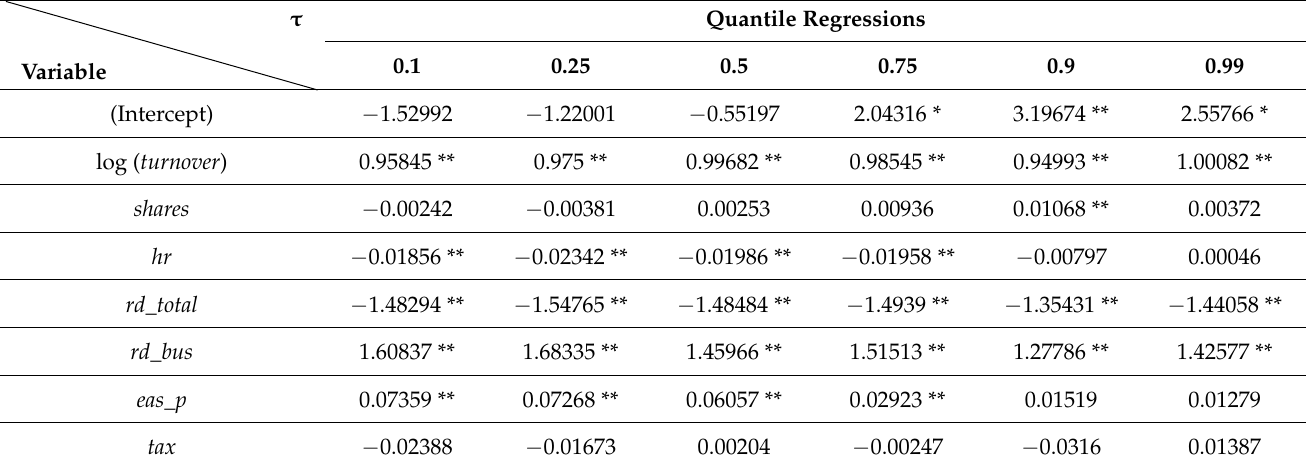
Table 3. Quantile Regression for Panel Data